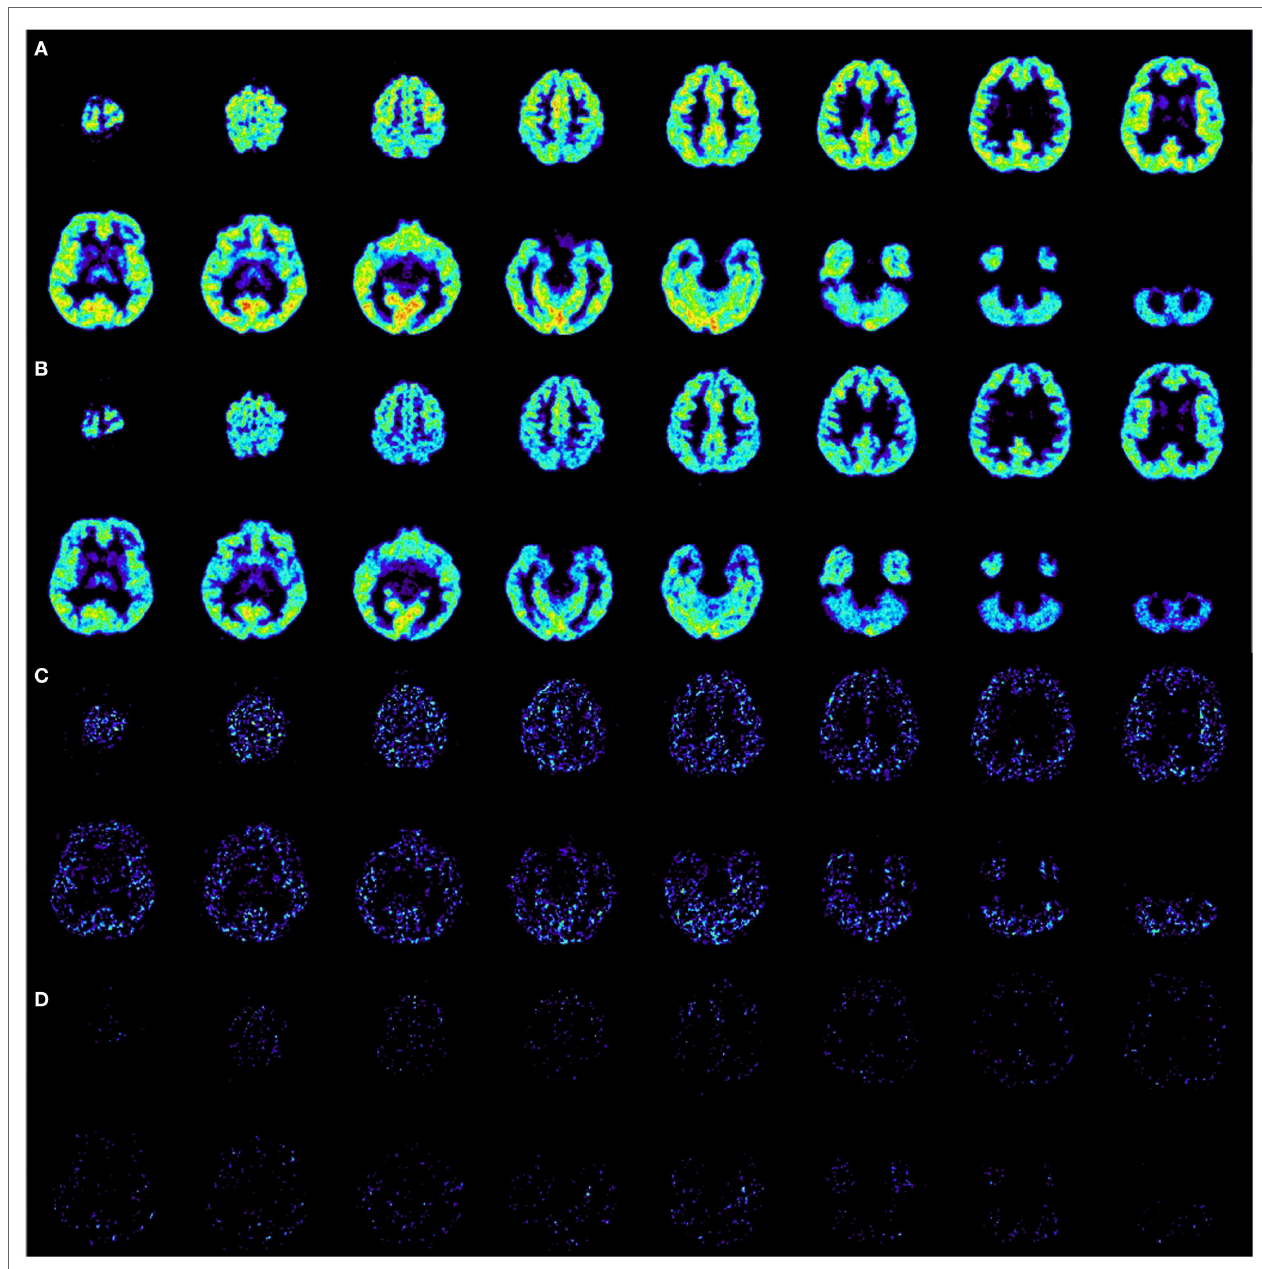
to injected activity 674 MBq with the same acquisition time from 20 to 40 min after injection. (C) Subtraction A–B, only positive results are displayed. A decrease of activity from A to B is clearly visible. (d) Subtraction B–A, only positive results are displayed. An increase of activity from A to B is hardly distinguishable from random